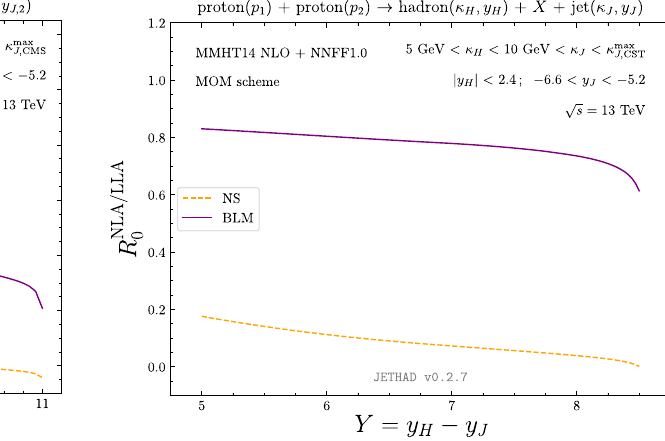
Fig. 6 Y -dependence of the R NLA reactions (Fig. 2) in the CASTOR-jet configuration and for TeV. Hadron emissions, when considered, are described in terms